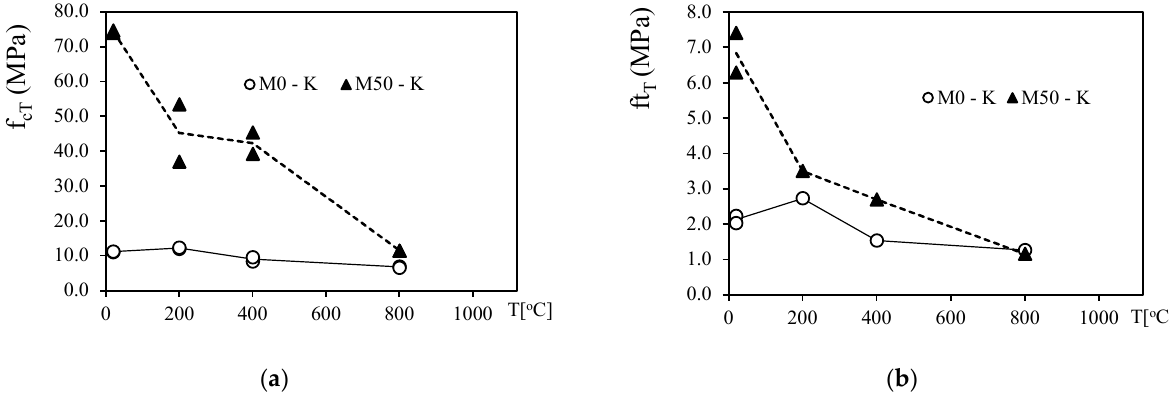
Figure 3. The changes of compressive and tensile strength with temperature (T) for M0-K and M50-K: ( a ) compressive strength f cT , ( b ) tensile strength, f tT .